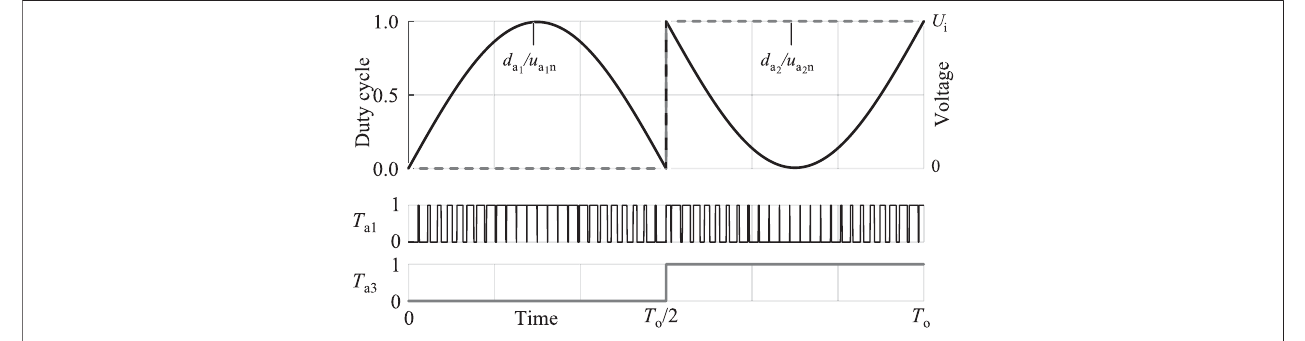
FIGURE 5 | Unfolder modulation: only the half-bridge a 1 is continuously operated with the switching frequency f s , while the second half-bridge a 2 of phase a is operated with the fundamental motor frequency f o .